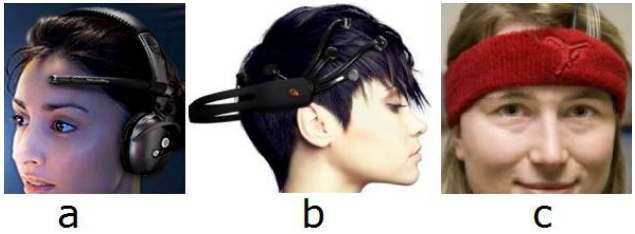
Fig. 2. BCI headsets (a) NeuroSky MindSet (b) Emotiv EPOC (c) fNIRS snsors covered with a headband. Sources: